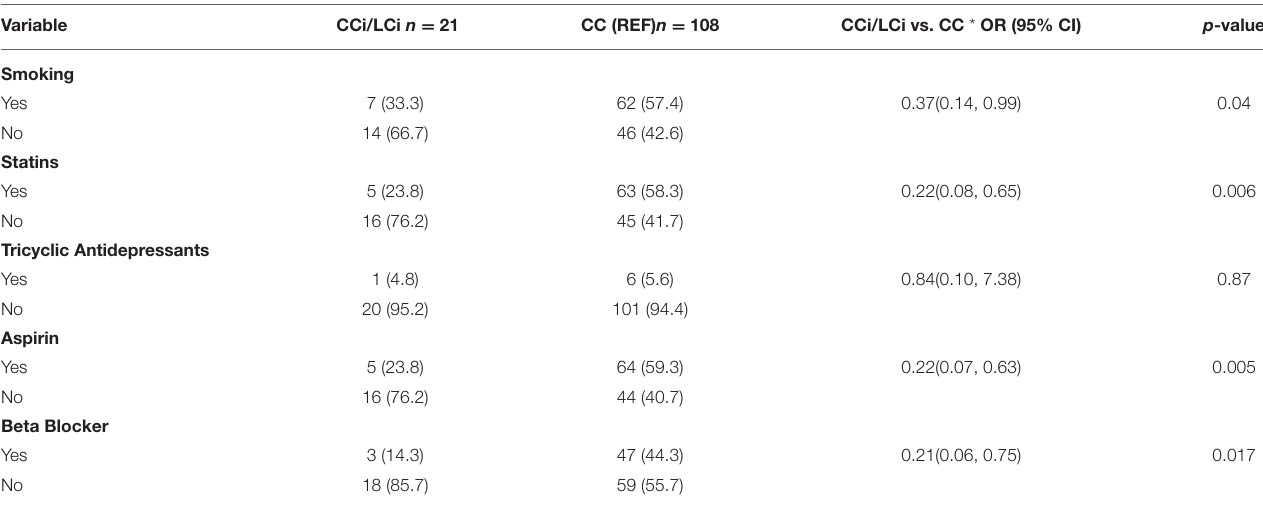
TABLE 3 | Association of smoking and medication with MCi compared with